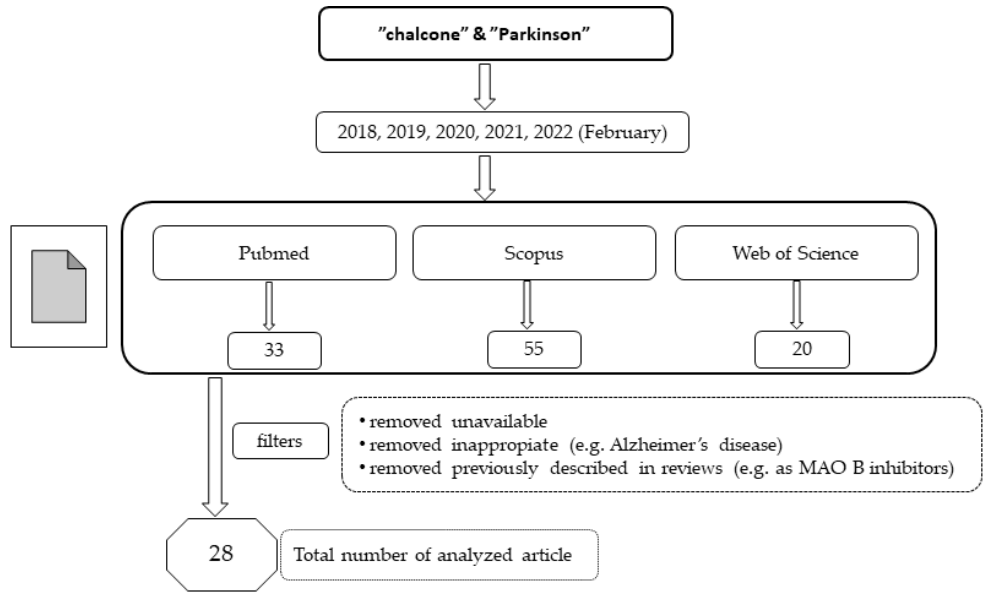
Figure 4. The way of selecting articles for this review.